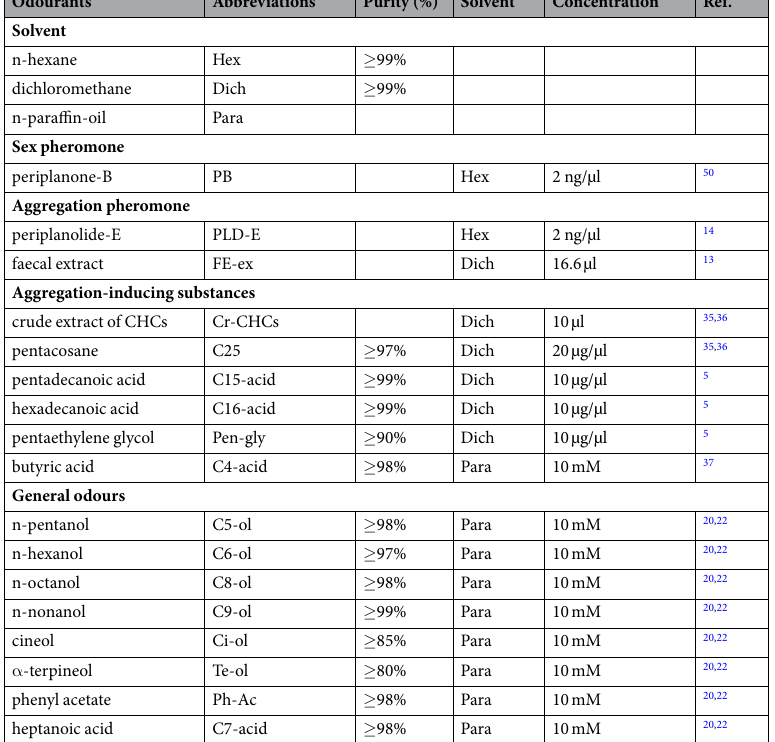
Table 1. Pheromones and odourants used in this